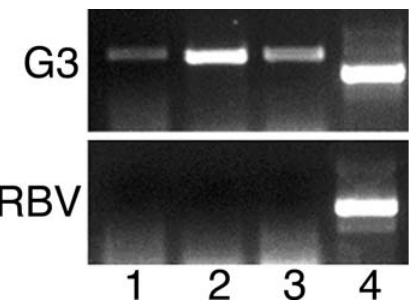
Figure 7. Determination of Transcripts of the Three Different Ehlgl Genes by RT PCR Total RNA was prepared from freshly harvested G3 and RBV trophozoites. PCR was performed using antisense conserved primer for Ehlgl1, Ehlgl2, and Ehlgl3 (Table 1, primer XV) and a specific sense primer for each of the genes as indicated. Lanes: 1, primer specific for Ehlgl1 (Table 1, primer XI); 2, primer specific for Ehlgl2 (Table 1, primer XVI); 3, primer specific for Ehlgl3 (Table 1, primer XVII); 4, primers specific for EhRPL21 (Table 1 primers II þ IX). DOI: